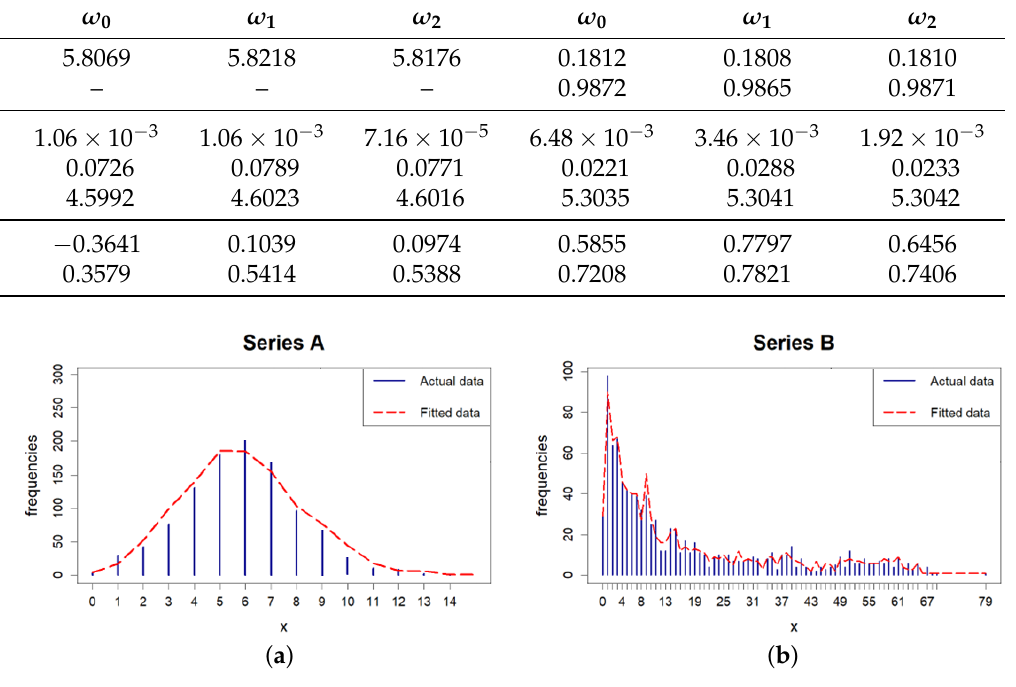
Figure 5. Frequency distribution of the actual and fitted data, obtained by ( a ) IID Poisson process; ( b ) INAR(1) process with geometric